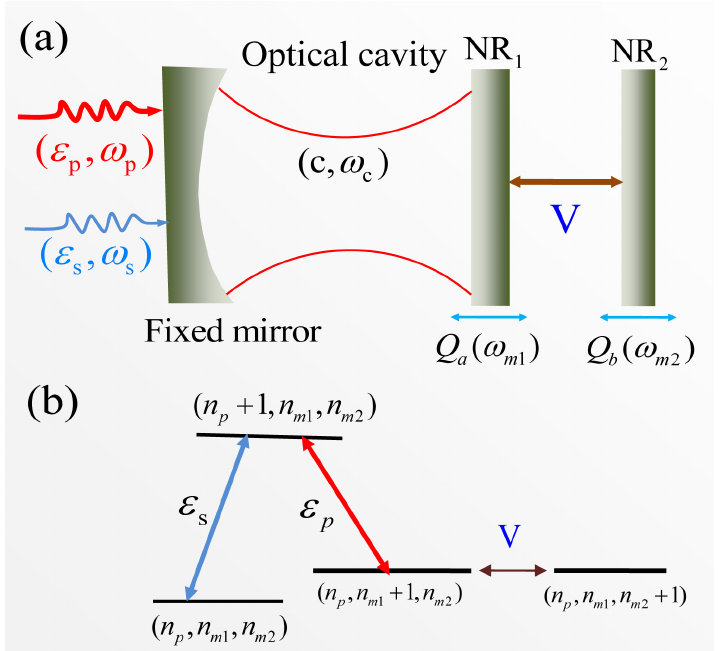
Figure 1. ( a ) Schematic diagram of the hybrid coupled optomechanical system including two coupled nanomechanical resonators (NRs) via Coulomb interaction. ( b ) Schematic of the energy-level diagram (cid:12) (cid:11) of the system. , | n m 1 (cid:105) , and | n m 2 (cid:105) denote the number states of the cavity photon, the phonons of (cid:12) n p NR 1 and NR 2 , respectively. V is the coupling strength of the two